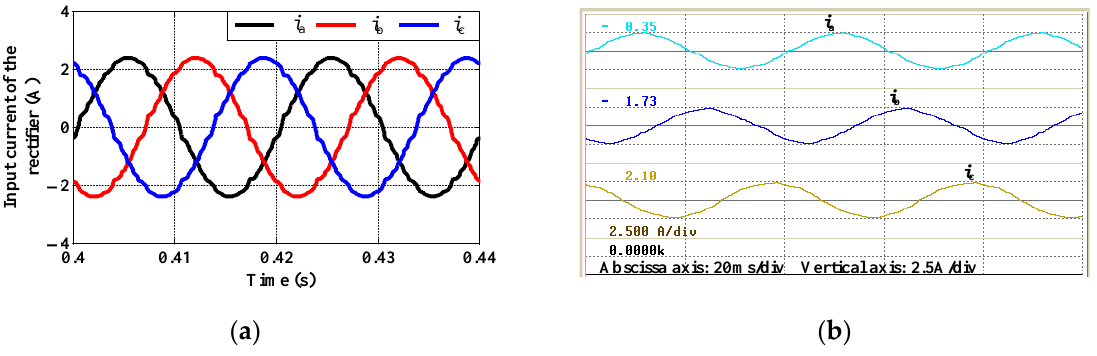
Figure 13. Input current of the rectifier without the reduction method. ( a ) Simulation result. ( b ) Experimental result. Figure 14 shows the input currents when using the hybrid harmonic reduction method.